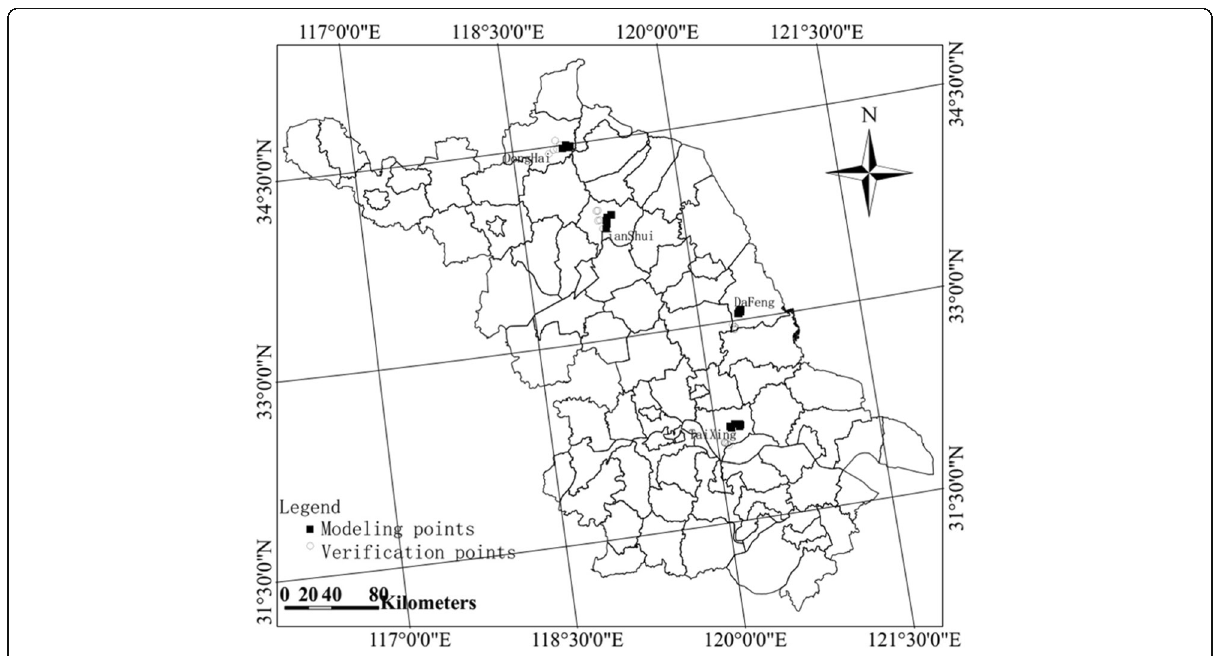
Fig. 1 Distribution of test sample points in Jiangsu